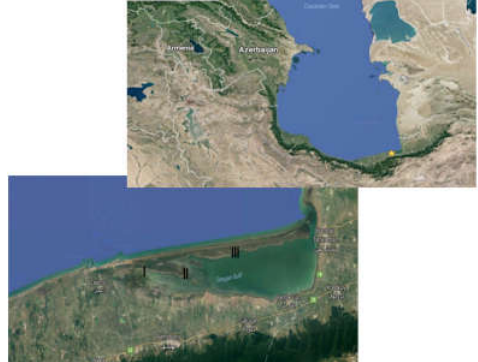
Fig. 1. Situation of Miankaleh Wetland showing the sites (I, II, III) used sampling in this